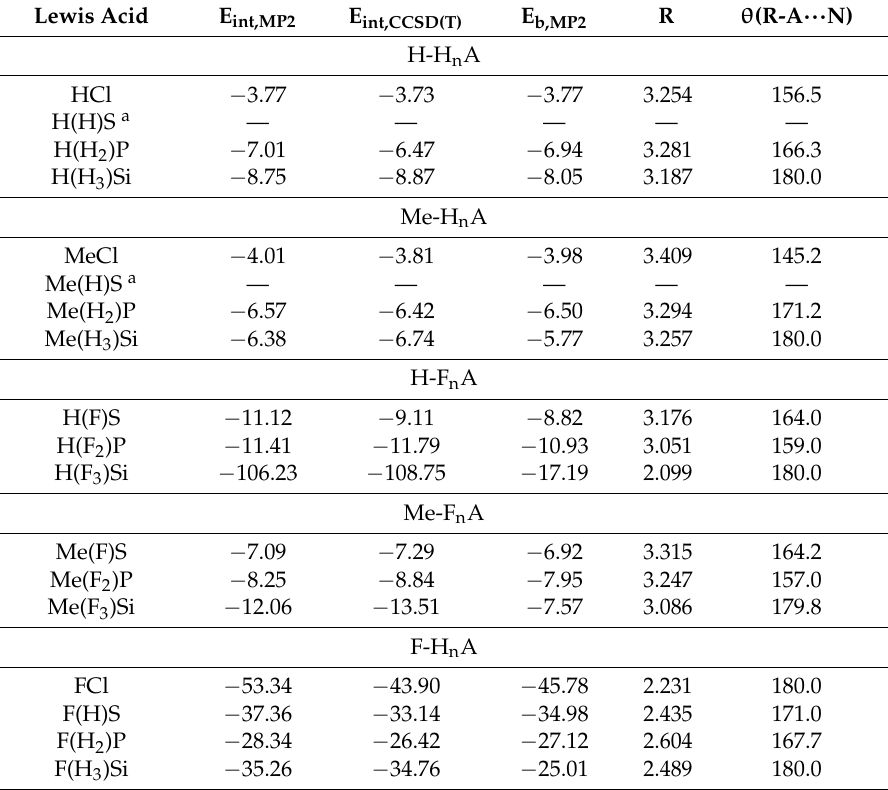
Table 5. Interaction energy (E int ), binding energy (E b ), intermolecular distance (R, Å), and angle θ (R-A ··· N)(deg) where R represents the atom directly opposite N. Energies are in kJ/mol. Lewis Acid E